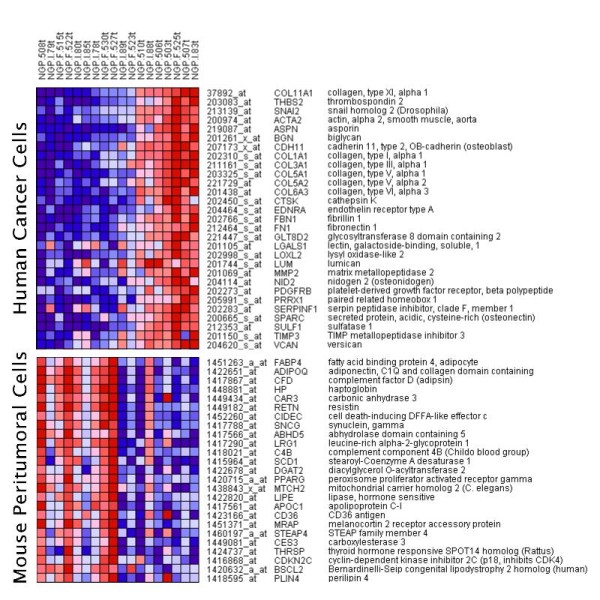
Heat map combining human and mouse genes. The 29 human genes include many EMT factors and were found to be significantly co-expressed in the cancer cells.